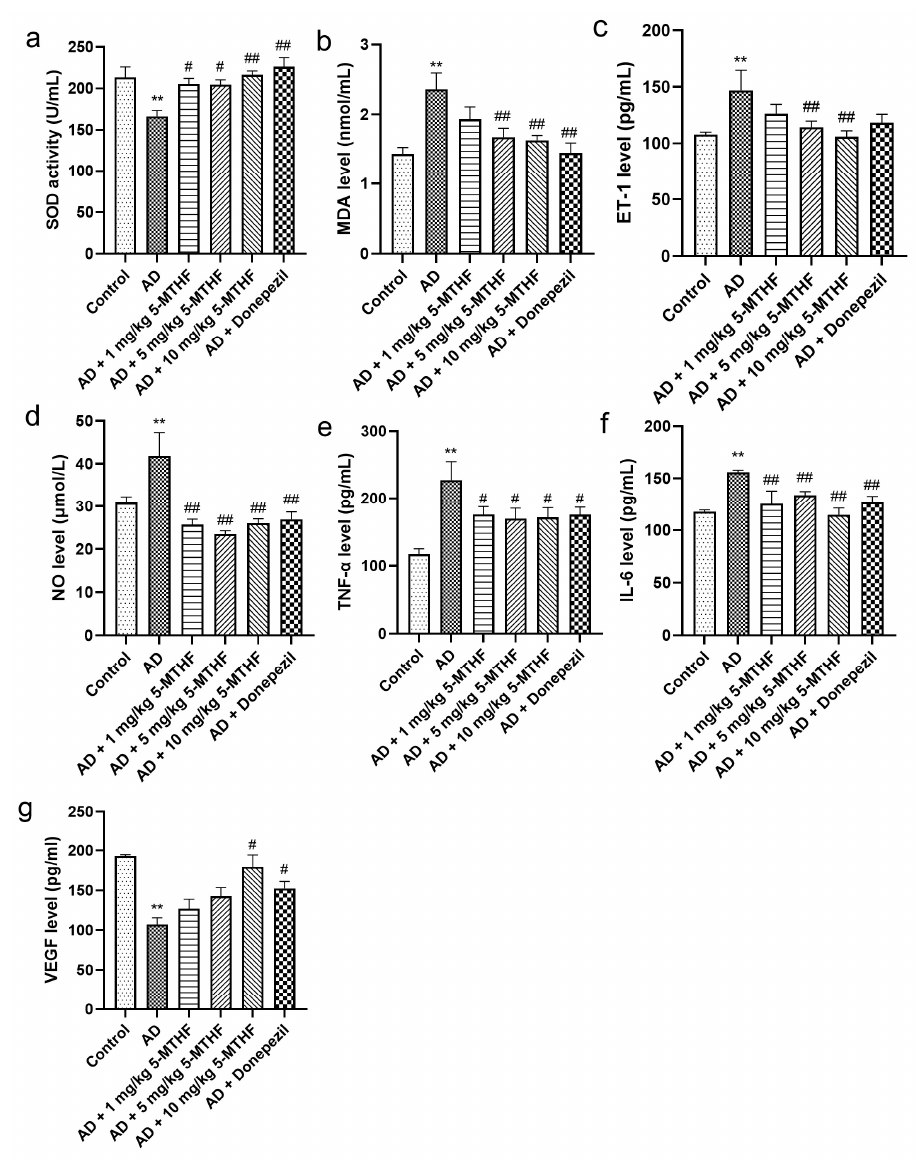
Figure 4. Serum antioxidant and cytokine indices. Antioxidants: ( a ) SOD activity and ( b ) MDA level. Cytokines: ( c ) ET-1, ( d ) NO, ( e ) TNF-α, ( f ) IL-6 and ( g ) VEGF. Data are shown as mean ± SEM. ** p